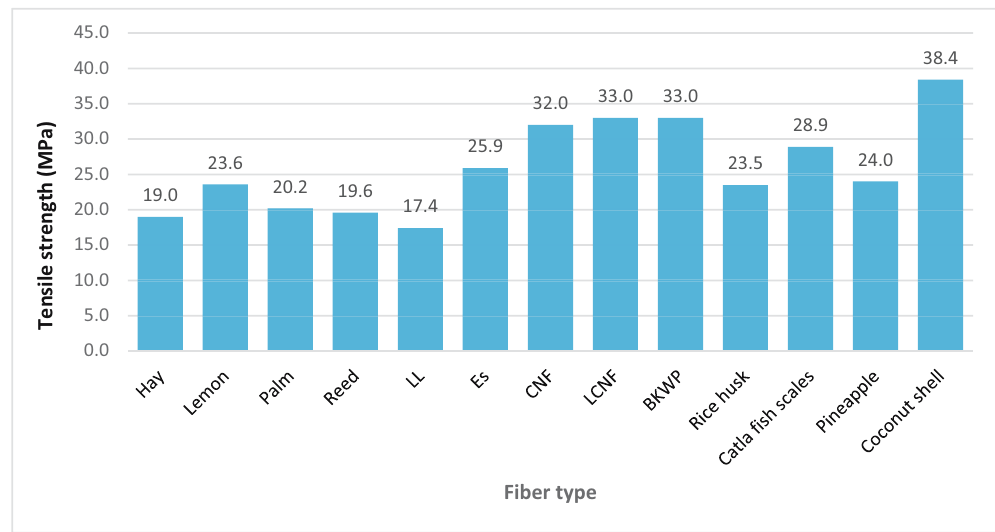
Figure 1: TS values of PP composites at 10 wt% of di ff erent natural fi llers.